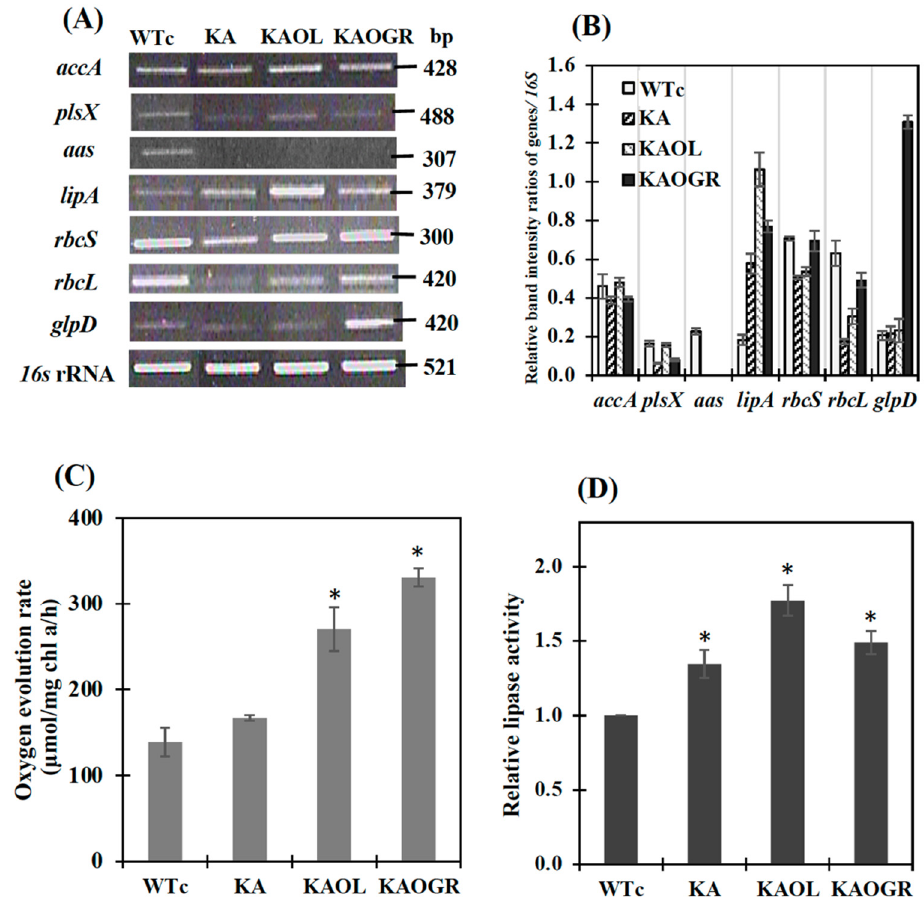
Figure 3. The transcript levels ( A ) and relative transcript intensity ratios ( B ) of the accA , plsX , aas , lipA , rbcS , rbcL , glpD and 16S rRNA genes in Synechocystis PCC 6803 strains WTc, KA, KAOL and KAOGR. Oxygen evolution rate ( C ) and relative lipase activity ( D ) of all strains. Cells were grown in BG 11 medium and analyzed at day 5 of cultivation. The error bars represent standard deviations of means (mean ± S.D., n = 3). For ( A ), agarose gel (1.2%) of PCR product stained by RedSafe TM nucleic acid staining solution (Intron Biotechnology Inc., Korea). For ( D ), control data (WTc) at 1.0 is derived from the lipase activity of 0.22 U/mg protein. For ( C ) and ( D ), the statistical differences of the results between WTc and engineered strain are indicated by an asterisk *, p < 0.05.